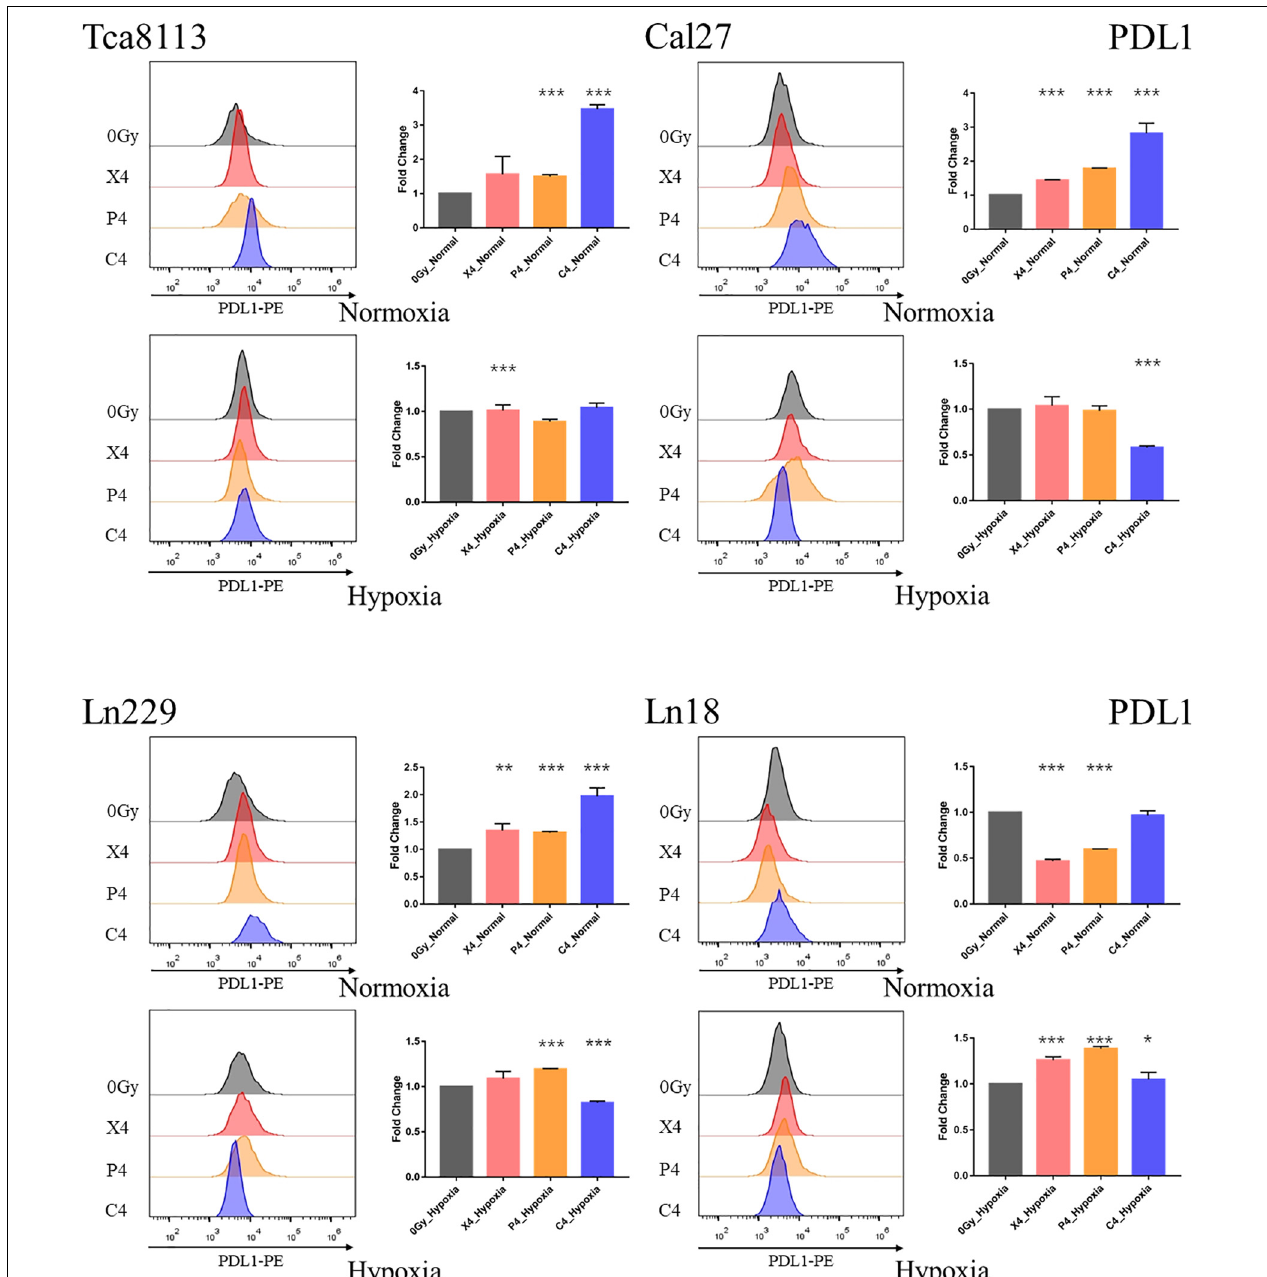
FIGURE 5 | Comparison of PDL1 expression under normoxia and hypoxia. Tumor cells were exposed to 4Gy physical dose photon, proton, or carbon-ion radiation. The expression level of PDL1 on the tumor cell surface was detected by flow cytometry 48 h after irradiation. Representative flow cytometry images of each group are shown in the half-offset histograms. The horizontal axis represents the fluorescence intensity of PDL1-PE, and the vertical axis represents the number of cells. The fold change of the MFI for each group relative to the control group (0Gy) is shown in the bar charts. Results are presented as mean ± s.d. Each experiment was repeated at least three times. Statistical significance of each irradiated group relative to the control group (0Gy) was indicated by asterisks. * p < 0.05, ** p < 0.01, and *** p <